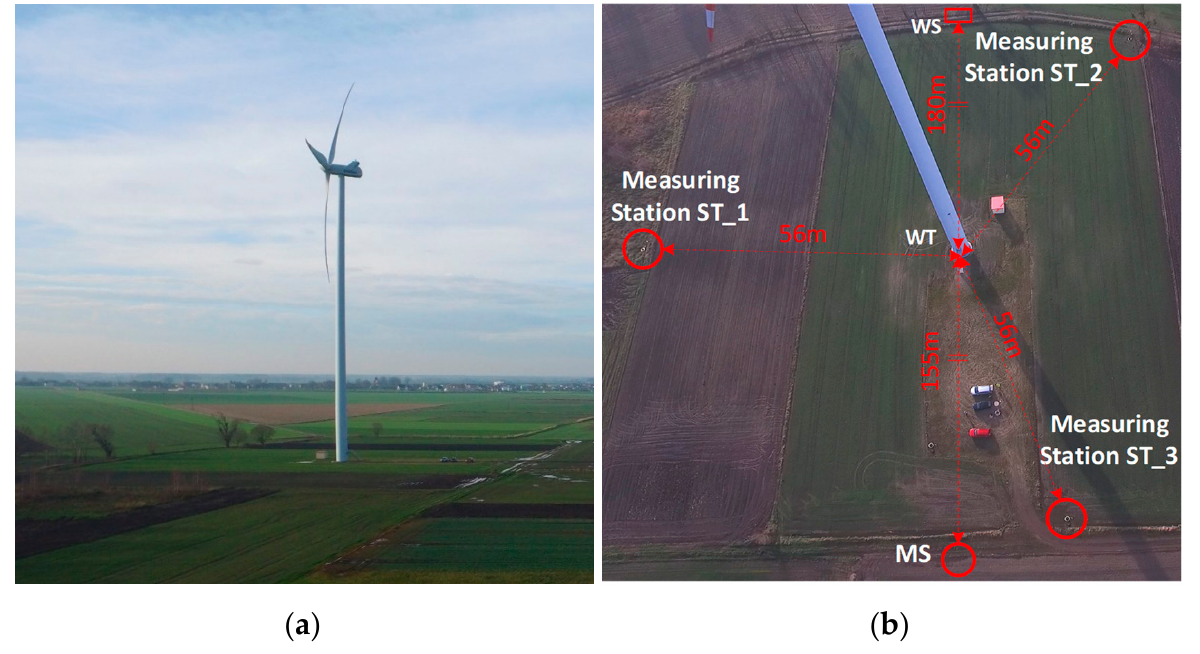
Figure 8. ( a ) General view of the wind turbine under the study; ( b ) Relative positions of the wind